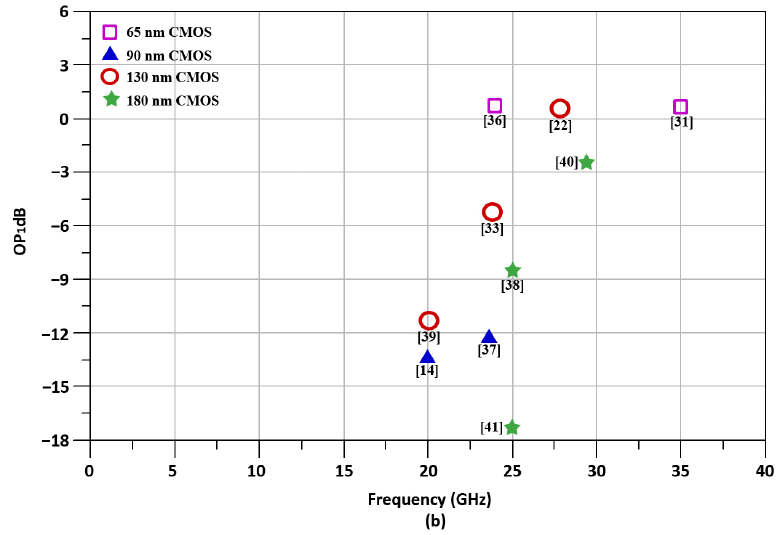
Figure 3. Literature survey of up-conversion mixers [14,22,31,33,36–41] with operating frequencies of 15–35 GHz. ( a ) Conversion gain, ( b ) OP 1